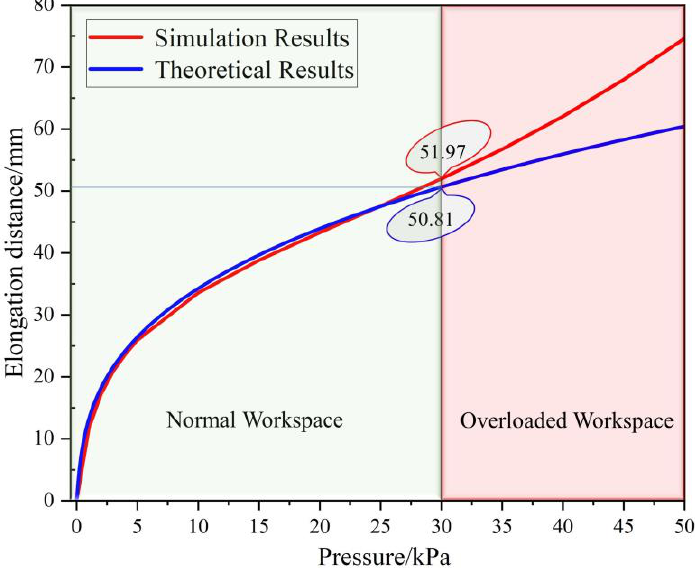
Figure 5. Comparison between the results of the simulation and the results of the numerical calcu-